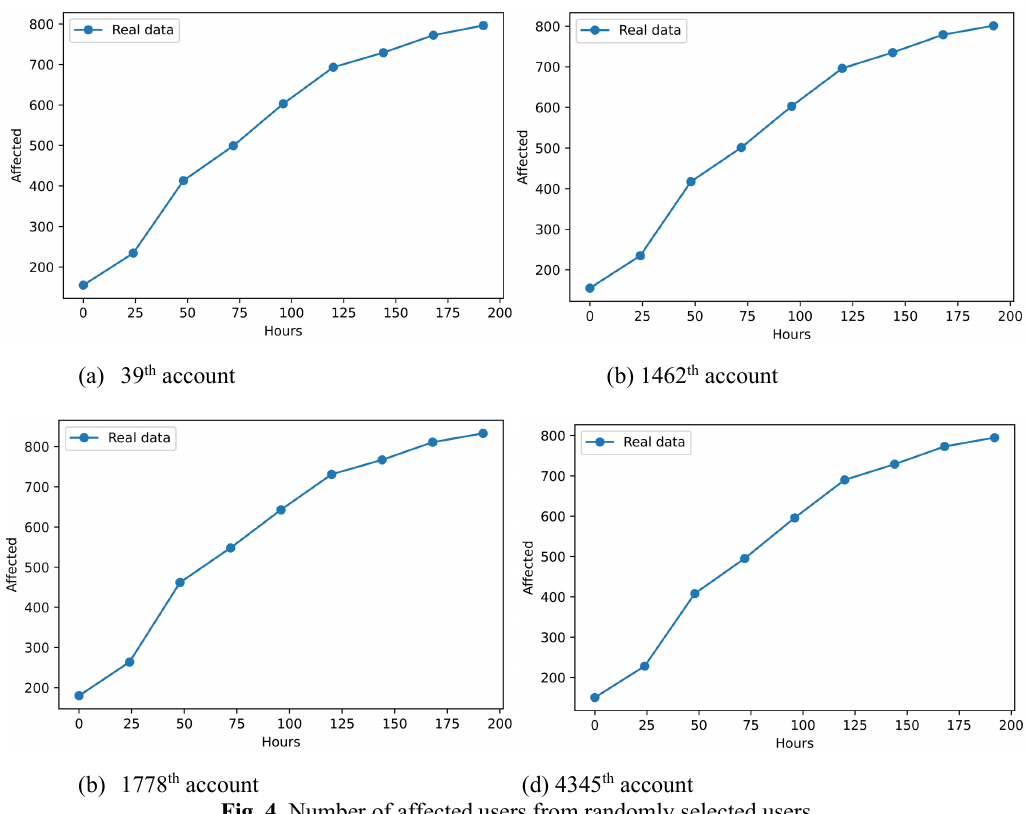
Fig. 4. Number of affected users from randomly selected users affected by the 1462 nd account in the training period, (c) the number of other users affected by the 1778 th account in the training time span, and (d) the number of other users affected by the 4345 th account in the training time span. From Fig. 4. we can see that the number of affected users is a function of time which is similar to a logarithmic function. This training data is used to estimate the values of a and b in Eq. (17). Furthermore, this logarithm function is used to obtain the value of 𝑛 over time. A visualization of the comparison of real data with the predicted number of affected users the predicted value of 𝑛 (cid:3036) from four randomly selected users is shown in Fig.